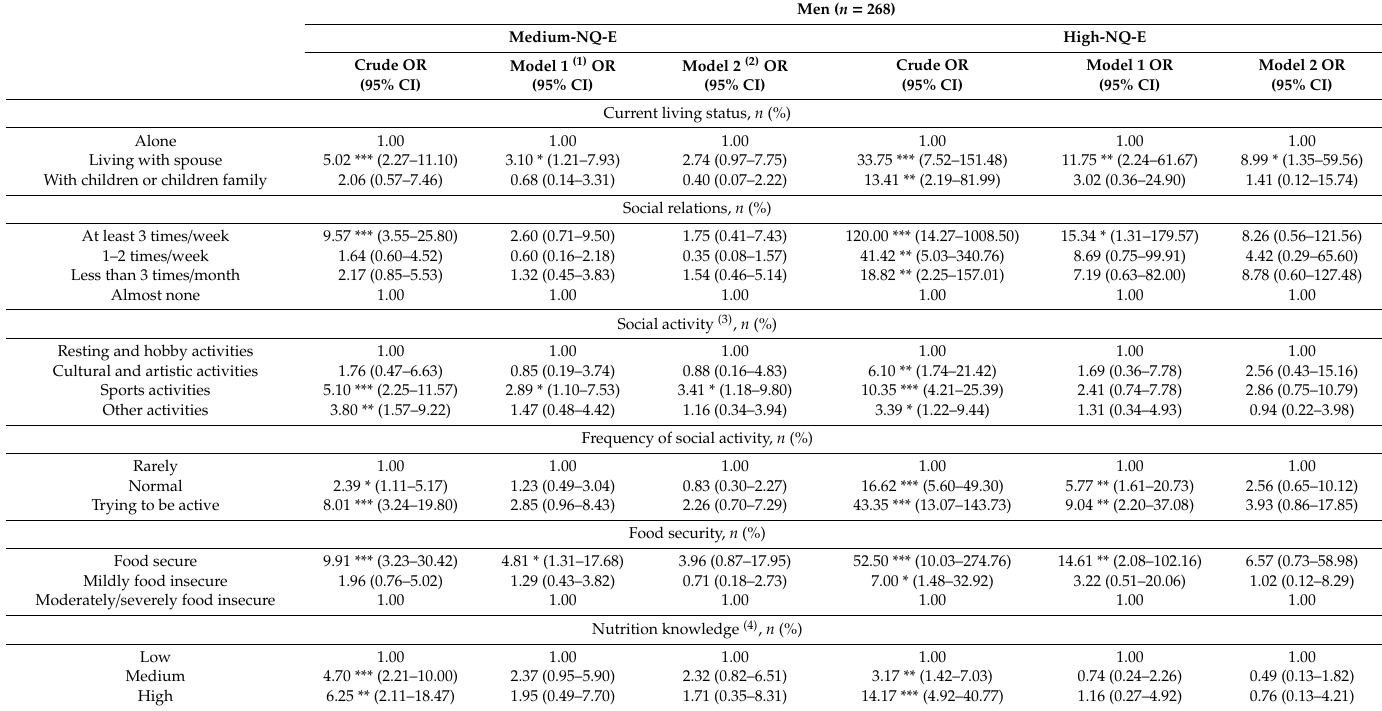
Table 5. Multinomial logistic regressions of an association between living environmental factors and NQ-E levels in elderly